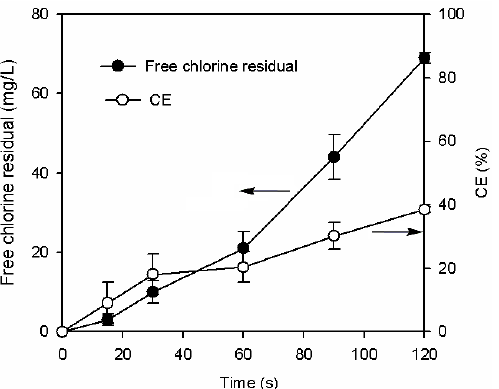
Figure 2. Free chlorine residual evolution and CE during the electrochemistry treatment of the spent caustic wastewater at 4 A.